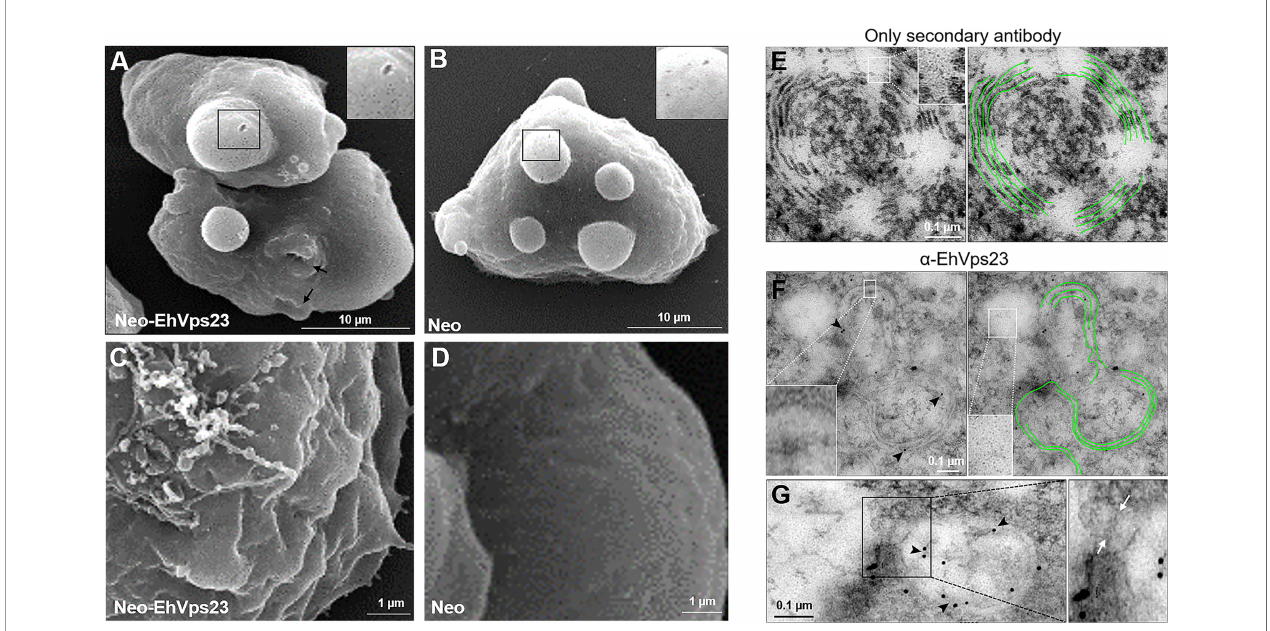
magni fi ed at the right. Arrows: phagocytic cups. (C, D) Show part of the surface of trophozoites (25,000x). (E – G) TEM of thin sections of trophozoites transfected with the pNeoEhvps23. The helicoidal structures are remarked in green. (F, G) TEM images were obtained after treating the thin sections with a - EhVps23 followed by gold-labelled a -rat antibodies. Squared areas are magni fi ed to show the very small vesicles in those regions. Arrowheads: label of the antibodies used to detect EhVps23. (F) The communication between vesicles where we visualized the presence of EhVps23 is shown. The magni fi cation shows the communication channel between the vesicles.